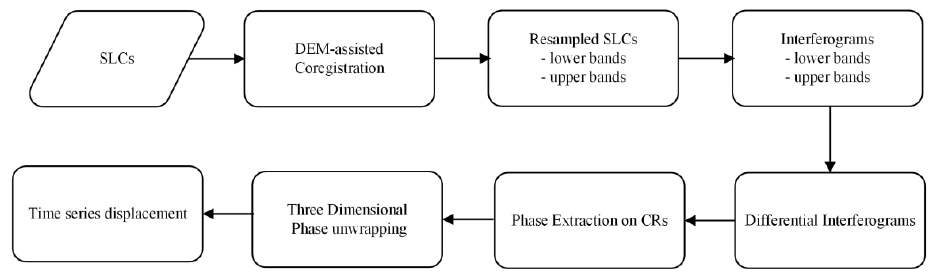
Figure 3. Diagram of Split-Bandwidth Interferometry process.